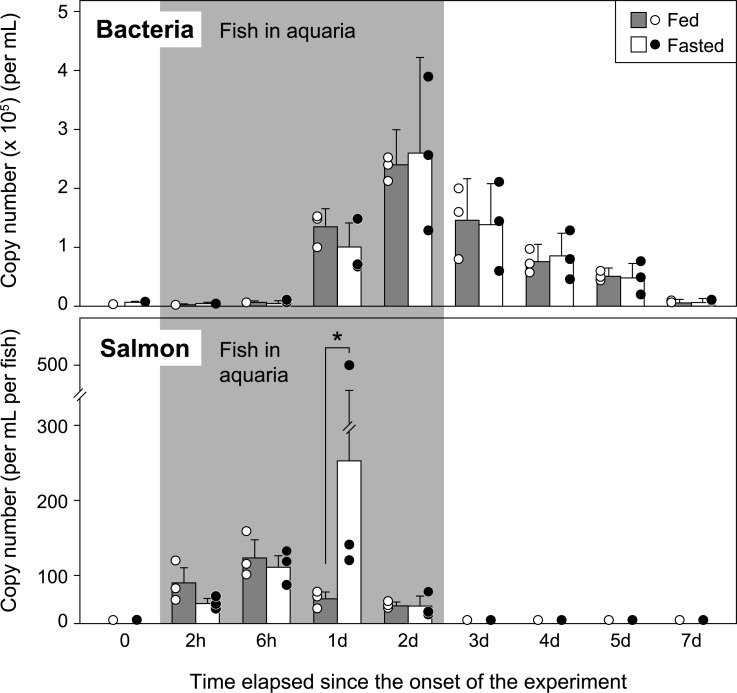
Temporal changes in chum salmon eDNA (lower panel; per mL water sample per fish) and bacterial gene amounts (upper panel; per mL water sample) in aquaria for the fed (shaded bars and white circles) and fasted groups (white bars and black circles). Bars and circles present the average and each value of the triplicate aquaria, respectively. Juvenile chum salmon was in aquaria during the shaded period. h and d indicate hours and days, respectively. An asterisk indicates a statistical significance (P<0.05).